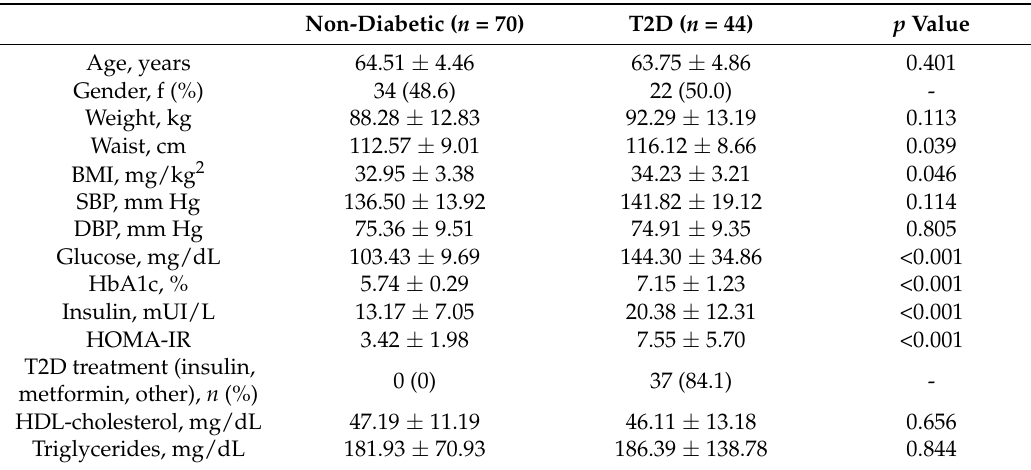
Table 1. Baseline clinical and biochemical variables of the study subjects, according to the presence or absence of